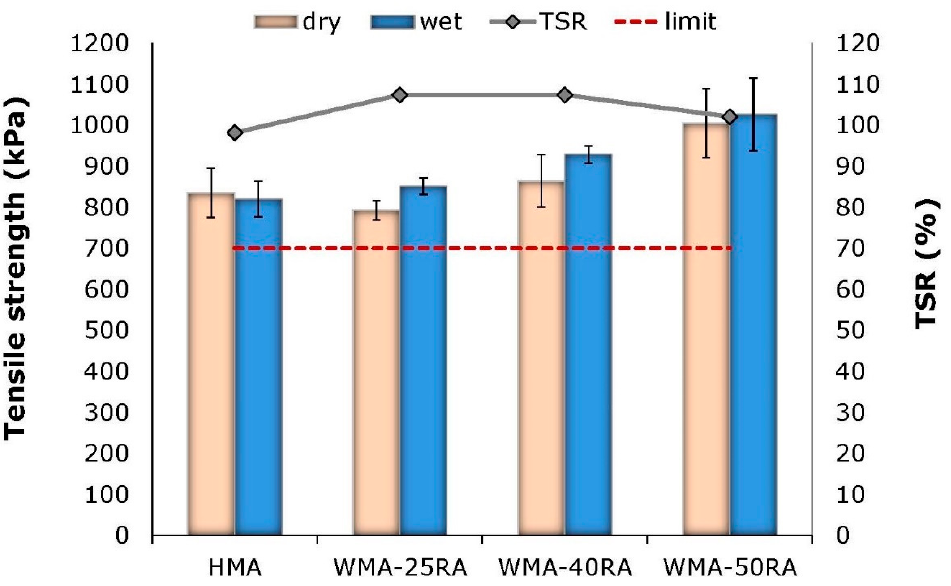
Figure 3. Indirect tensile strength and TSR values.